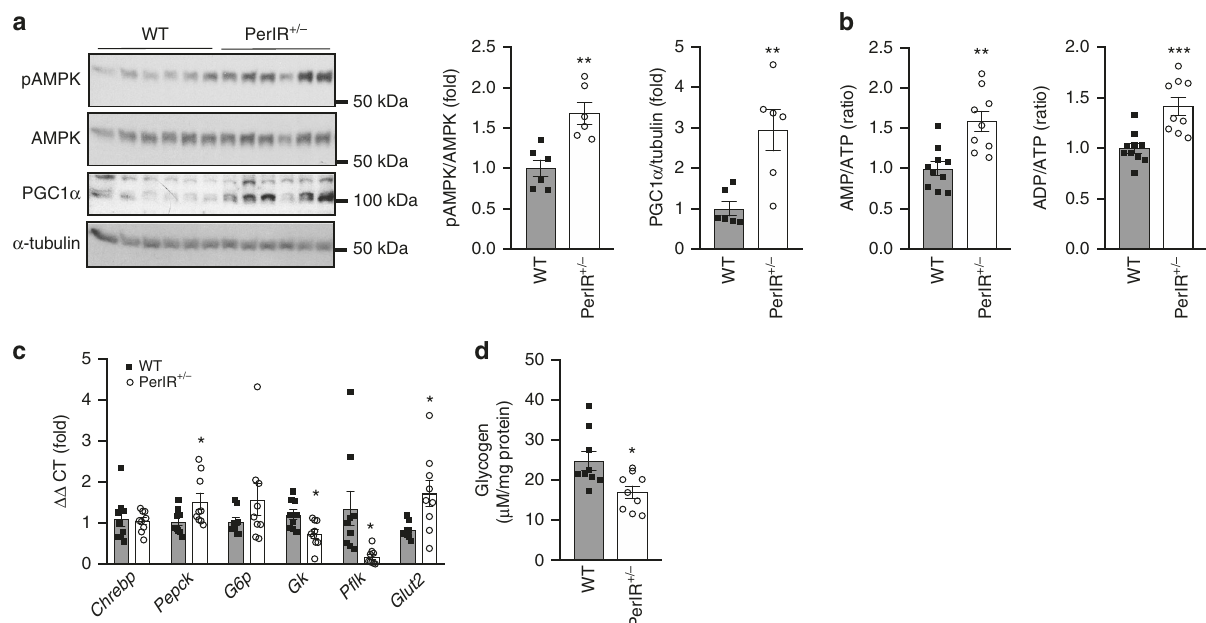
Fig. 3 Partial peripheral tissue IR disruption induces an energy defect in the liver of adult mice fed a high-fat diet. Ten weeks following high-fat diet (HFD) feeding the livers of male WT and PerIRKO + / − were collected and AMPK activation (phosphorylation), PGC1 α expression a , ATP, ADP, AMP levels b , expression of glucose metabolism genes c , and glycogen content d was determined. Results are shown as means ± SE, with n ’ s represented as individual data point ’ s in fi gures. Signi fi cance was determined using two-tailed student ’ s t test; * p < 0.05, ** p < 0.01, *** p < 0.001 vs